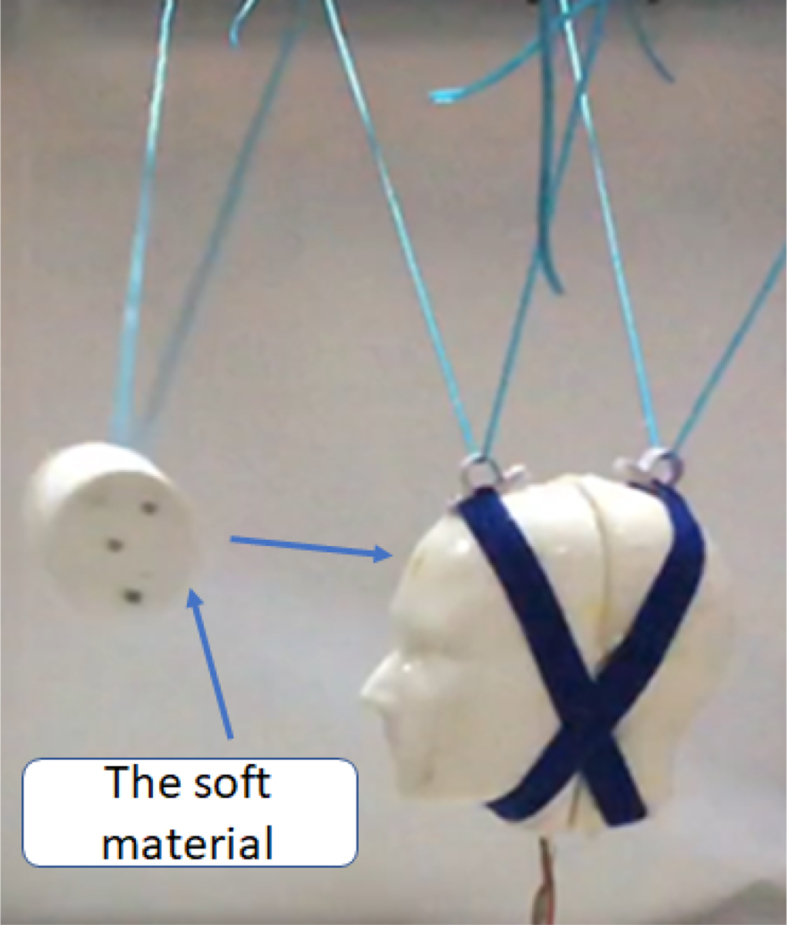
A sample of the experiments [7].